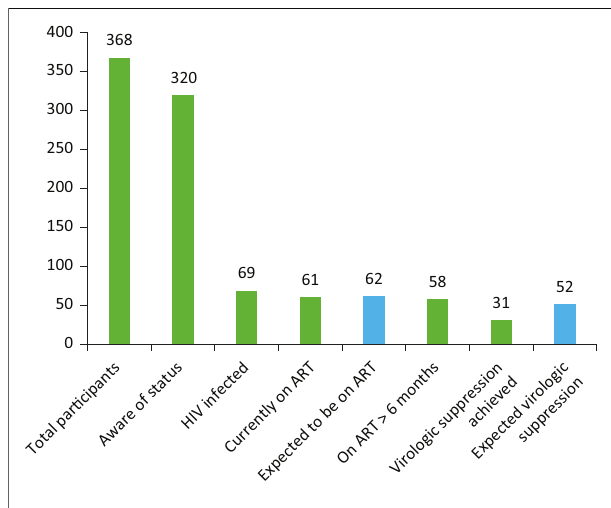
FIGURE 3: HIV cascade of care.